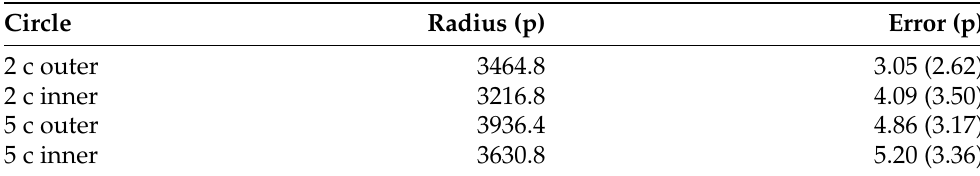
Figure 17. Edges belonging to the inner and outer creases of two coins ( left ) and edge detection details ( right ). Table 7. Mean circle fit error and standard